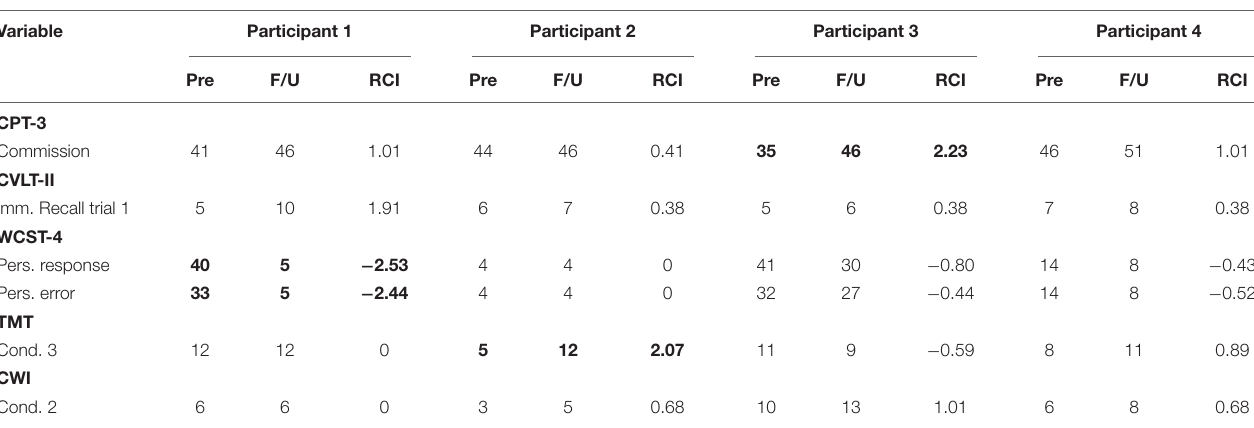
TABLE 5 | Reliable change index for neurocognitive